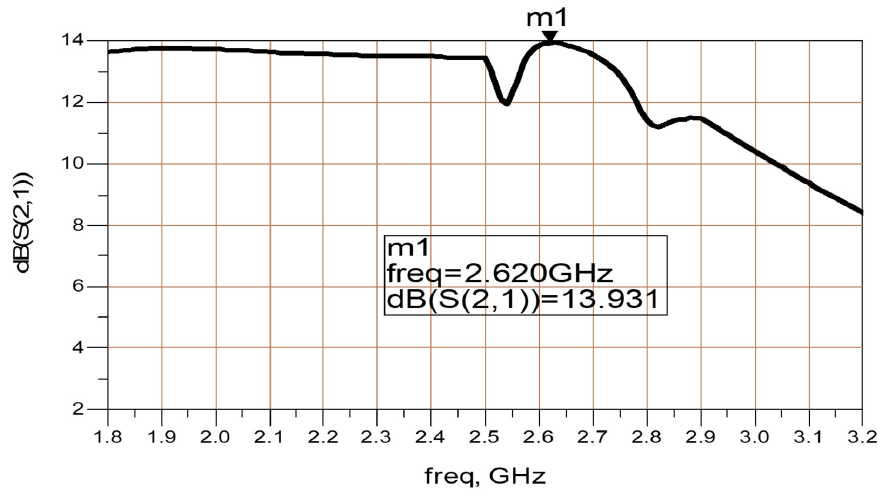
Figure 21. Measured S11 parameters of the circular polarized transmitting channel.